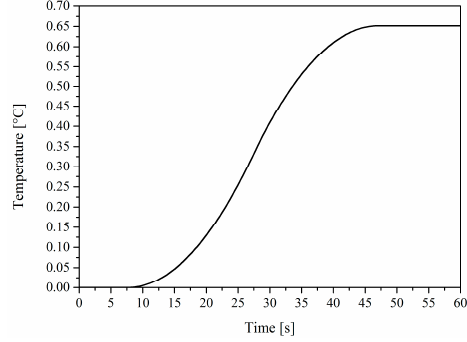
Figure 4. Temperature response for the triangular heat flux.